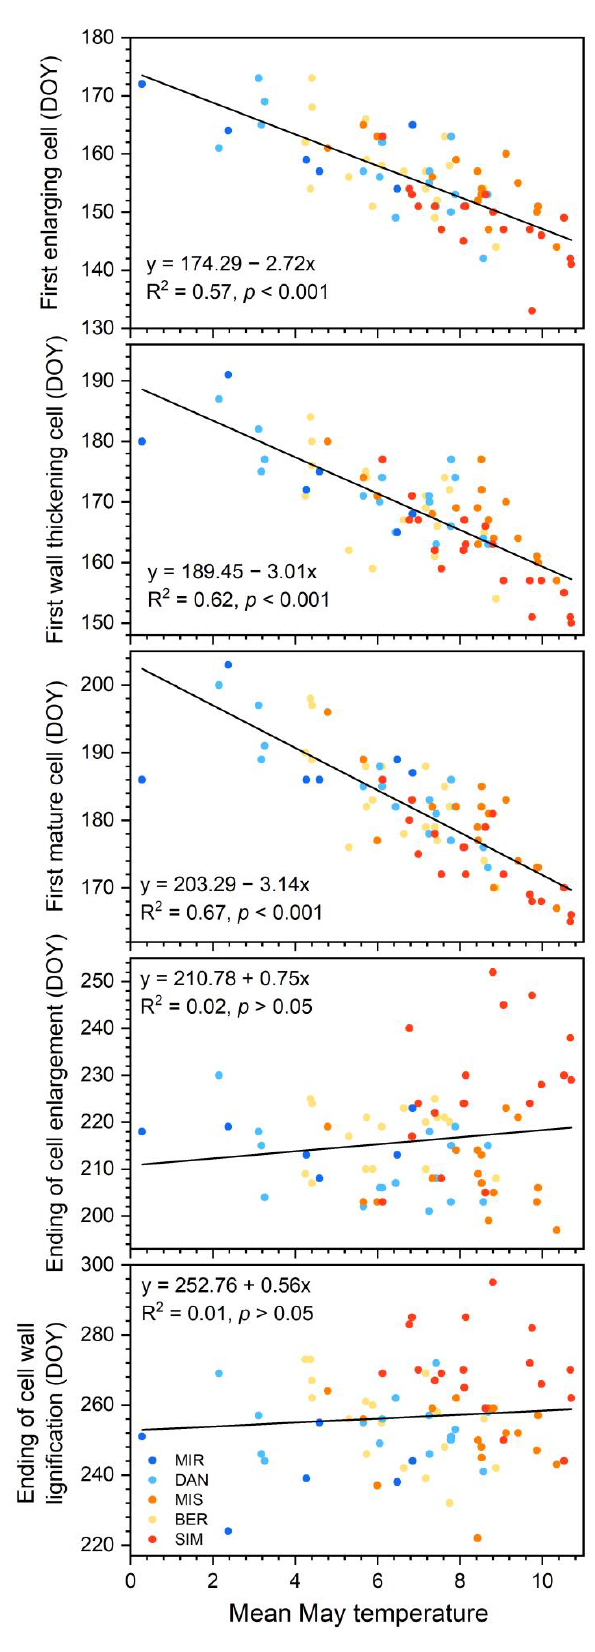
Figure 7. Relationships between the mean May temperature and xylem phenology at the five permanent sites in the boreal forest of Quebec,